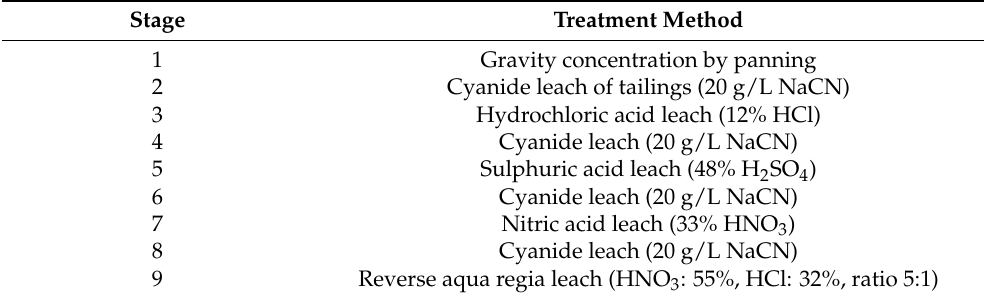
Table 4. Diagnostic leach